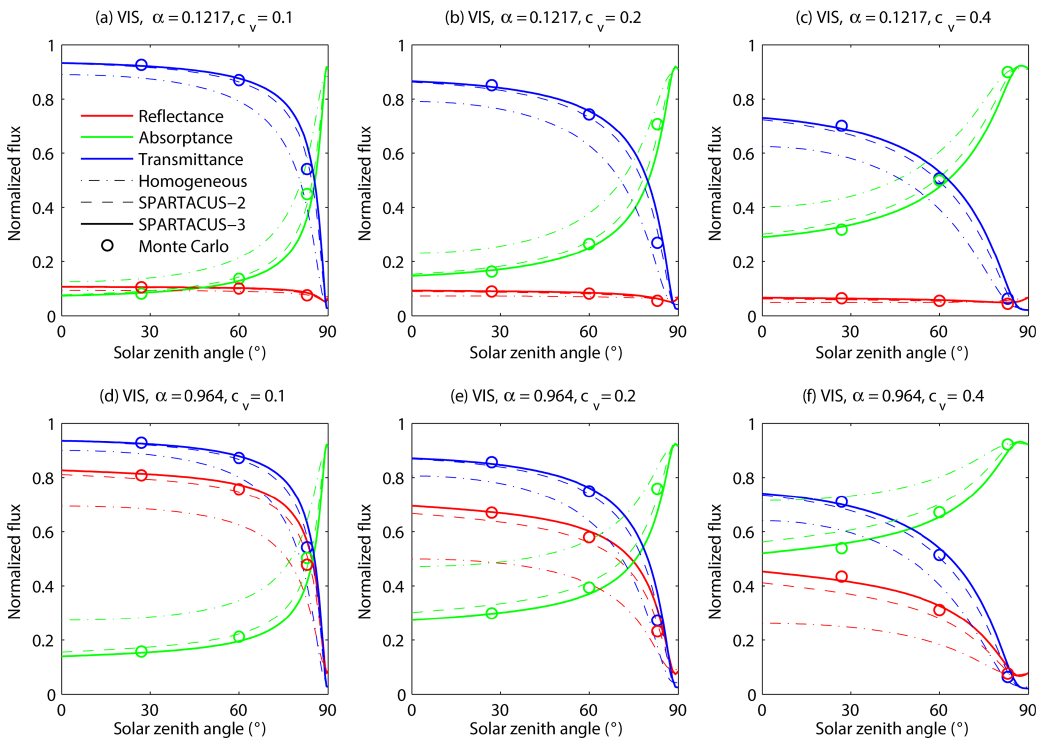
Figure 4. As Fig. 2 but for the RAMI4PILPS “Shrubland”